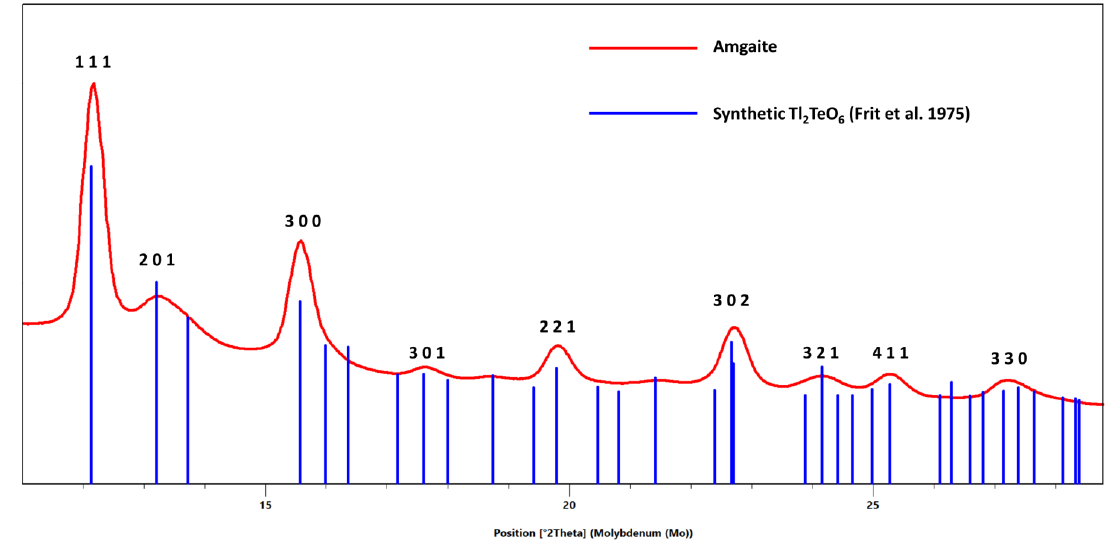
Figure 6. Powder micro-X-ray diffraction pattern for amgaite compared with the lines of synthetic Tl 3+2 Te 6+ O 6 [20]. The most important diffraction peaks are labeled with their relative Miller indices. The unit – cell parameters were calculated from the observed d spacings reported in Table 3 using UNITCELL software [21]. Amgaite is trigonal, from space group P 321(#150), a = 9.0600(9), c = 4.9913(11) Å , V = 354.82(8) Å 3 ; Z = 3. These data are in very good agreement with the synthetic Tl 3+2 Te 6+ O 6 described by [20]. For comparison, the unit – cell data of the synthetic analogue are: a = 9.070, c = 4.984 Å , V = 355.1 Å 3 . Table 4. Atomic coordinates and interatomic distances for synthetic Tl 3+ 2 Te 6+ O 6 [20]. Atom x y z B